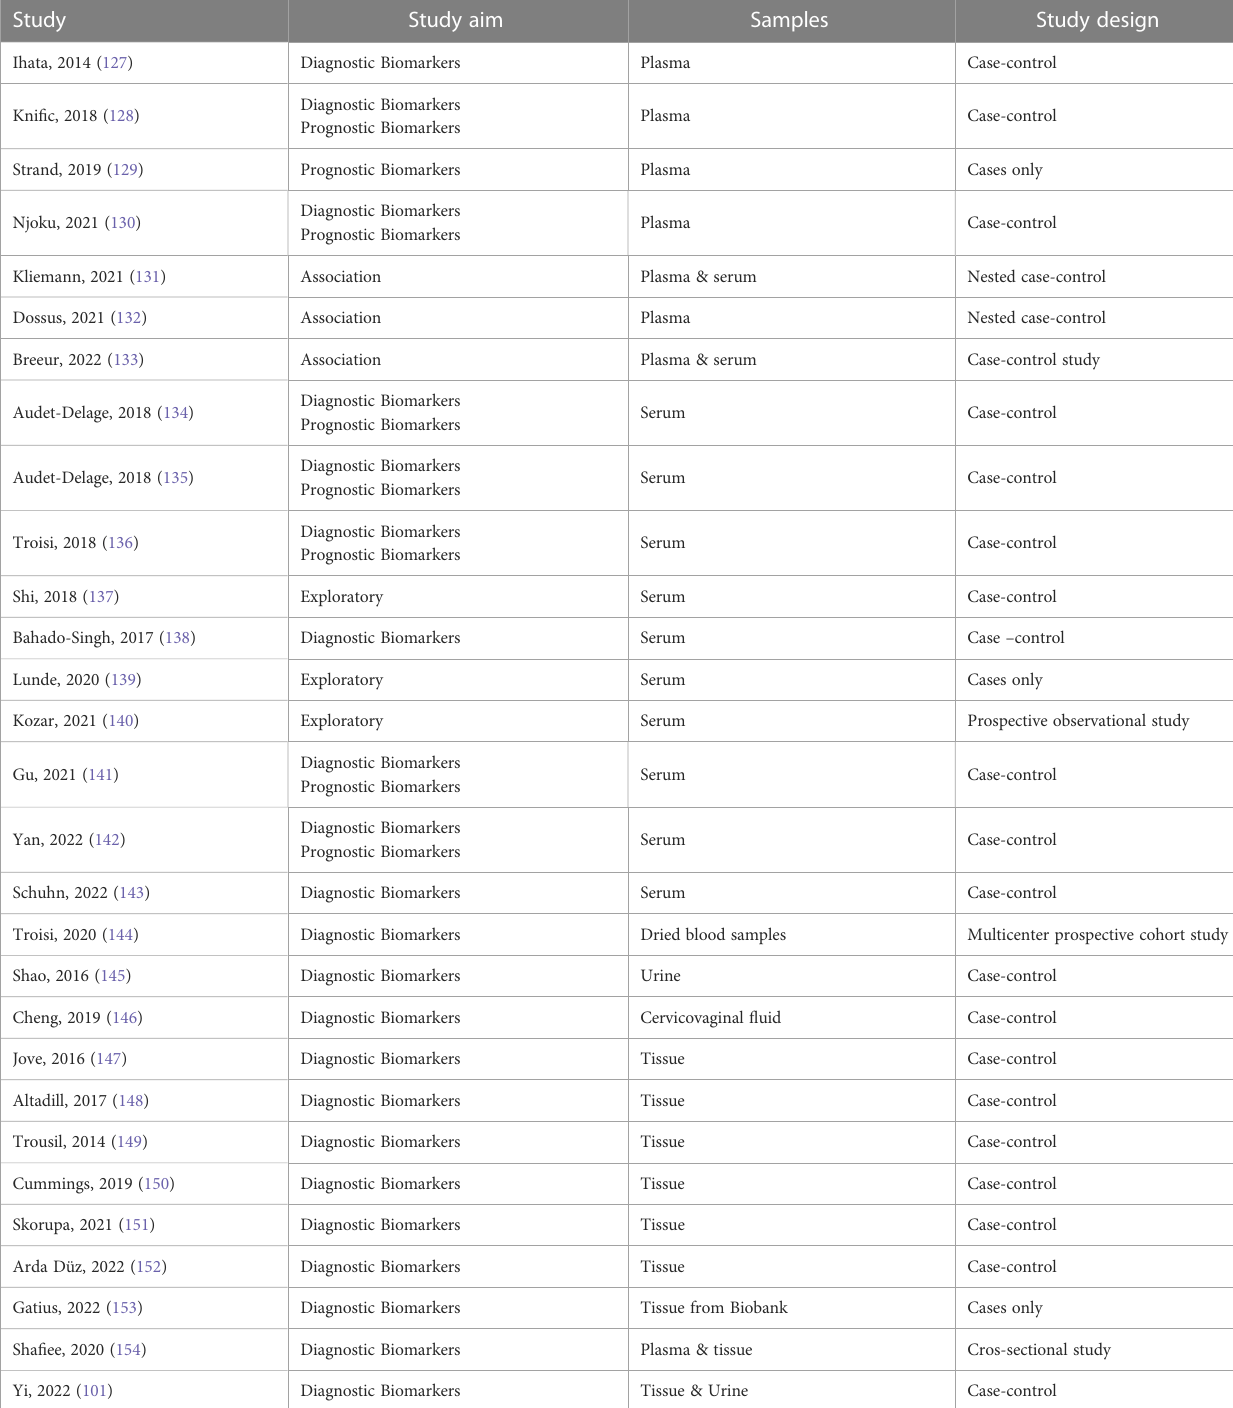
TABLE 4 List of the 29 metabolomic studies in endometrial